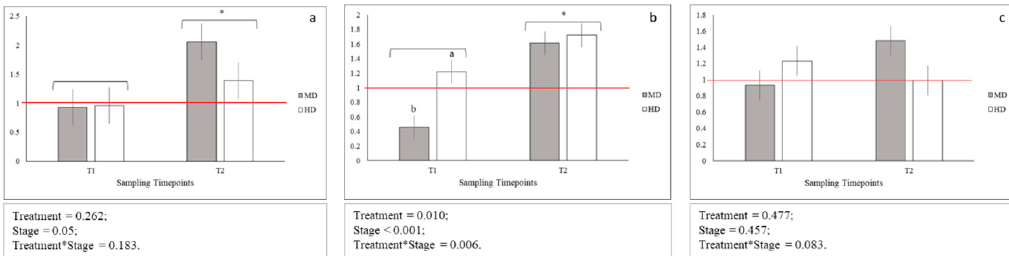
Figure 4 . Relative gene expression of: ( a ) igf1 ; ( b ) igf2 ; ( c ) myog ; Means with asterisks differ significantly between stages of development ( p < 0.05); A,B Means with different superscripts differ significantly between treatments ( p < 0.01); a,b Means with different superscripts differ significantly between treatments ( p < 0.05); red line indicates the up- and down-regulation limit.